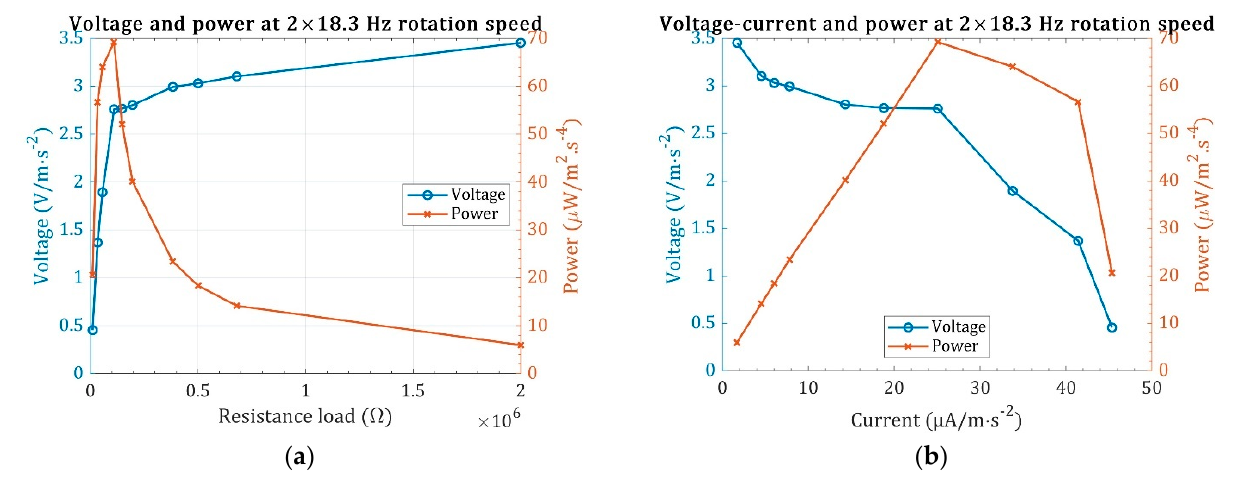
Figure 12. Finding the optimum load for the highest power generation. ( a ) The voltage and power versus the resistance load, and ( b ) the voltage-current and power-current curves.